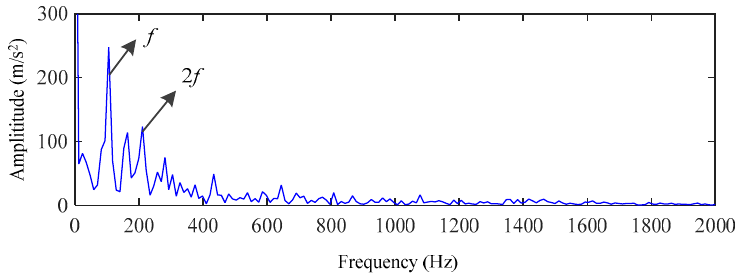
Figure 23. The envelope spectrum of the optimal component for outer ring defect by using EMD.